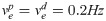
A theoretical framework for single cell computation in the fluctuation-driven regime: Cellular model and two-step approach for the input-output function.(A) Theoretical paradigm: to get the input-output function of a single cell, we split the relation from presynaptic quantities (the input) to the spiking probability (the output) into two steps. 1) passive dendritic integration shapes the membrane potential at the soma and 2) how those fluctuations are translated into spikes is captured by a firing response function determined in vitro. (B) Theoretical model for dendritic integration. A single cell is made of a lumped impedance somatic compartment and a dendritic tree. The dendritic tree is composed of B branches (here B = 5), the branching is symmetric and follow Rall's 3/2 rule for the branch diameters. Synapses are then spread all over the membrane according to physiological synaptic densities. We define 3 domains: a somatic and proximal domain as well as a distal domain, excitatory and inhibitory synaptic input can vary independently in those domains. An additional variable: synaptic synchrony controls the degree of coincident synaptic inputs. (C) A given presynaptic stimulation (here νep=νed=0.2Hz, νip=νid=1.2Hz and s = 0.05) creates membrane potential fluctuations at the soma characterized by their mean μV, their amplitude σV and their autocorrelation time τV.